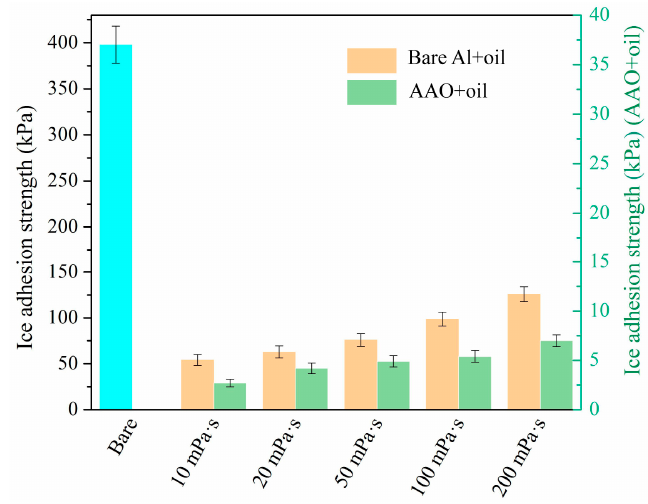
Figure 6. Ice adhesion strength of the various viscosities (10–200 mPa·s) of silicone oil infused with bare Al and nanoporous